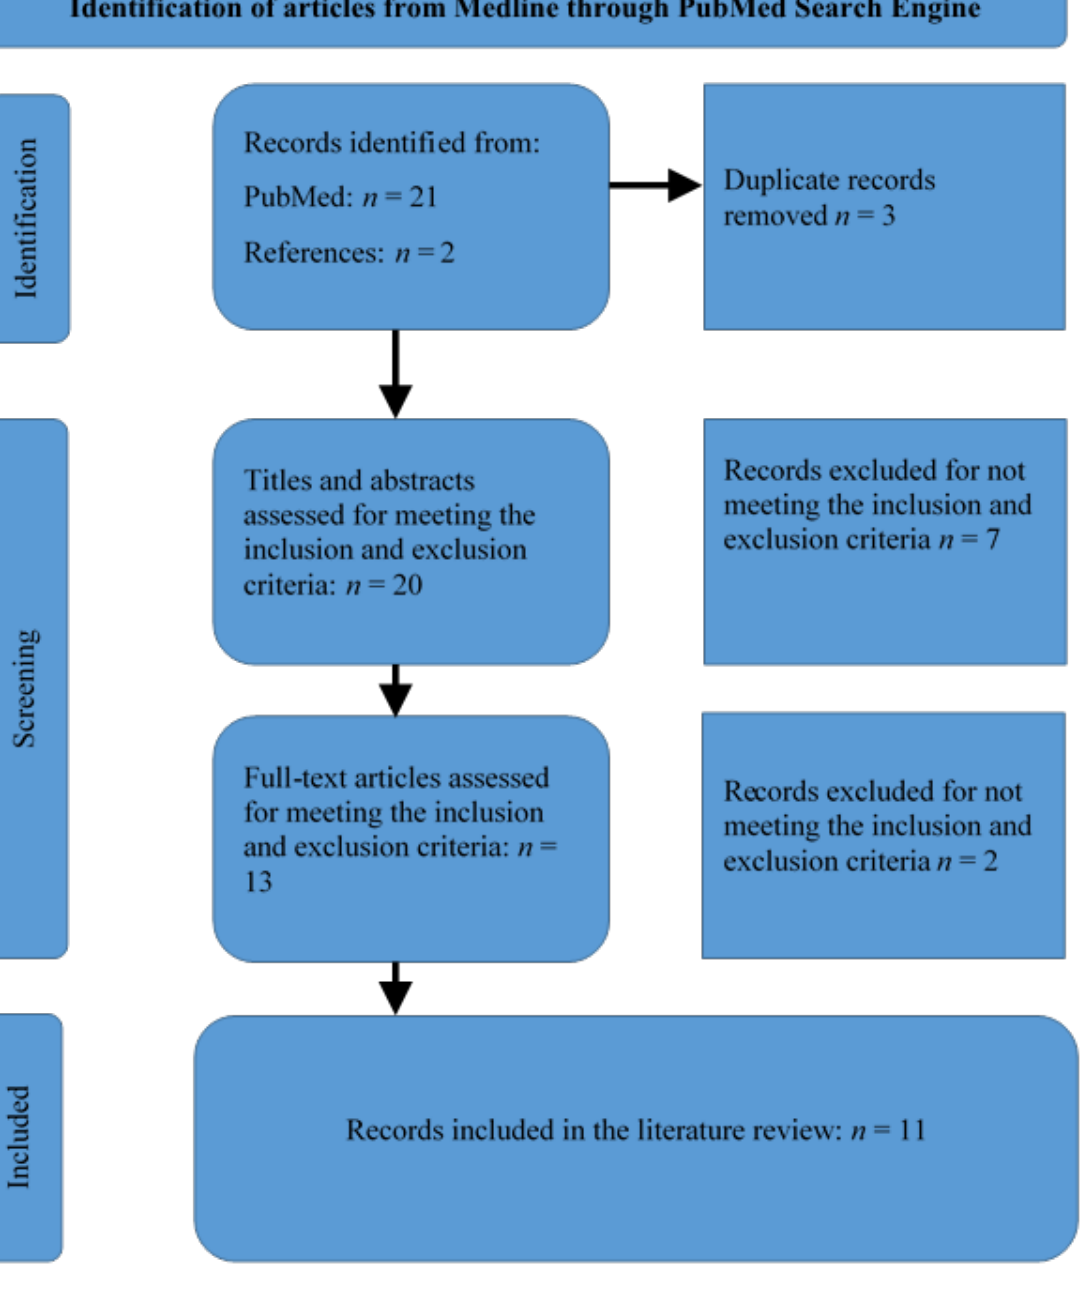
Figure 1. Selection of articles for the review. 106